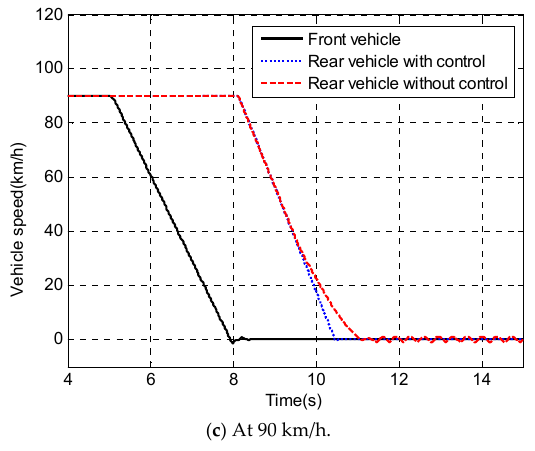
Figure 7. Velocity profile of braking.